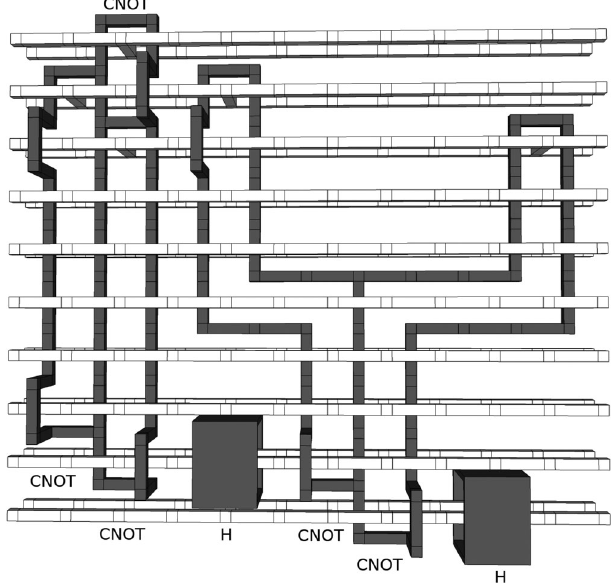
U-shape.FIG. 23. Surface code implementation of the inner loop of the Majorana operator circuit. Contrast with Fig. 9, noting that the circuit has been somewhat modified to reduce its surface code spacetime volume. In particular, the controlled- Y operations from Fig. 9 have been propagated through the controlled- Z operations, producing CNOT operations that are cheaper to perform. This creates phase error, which must be corrected by an S gate on the control of the entire Majorana operator. Here, we do not show initial Hadamard gates on every target